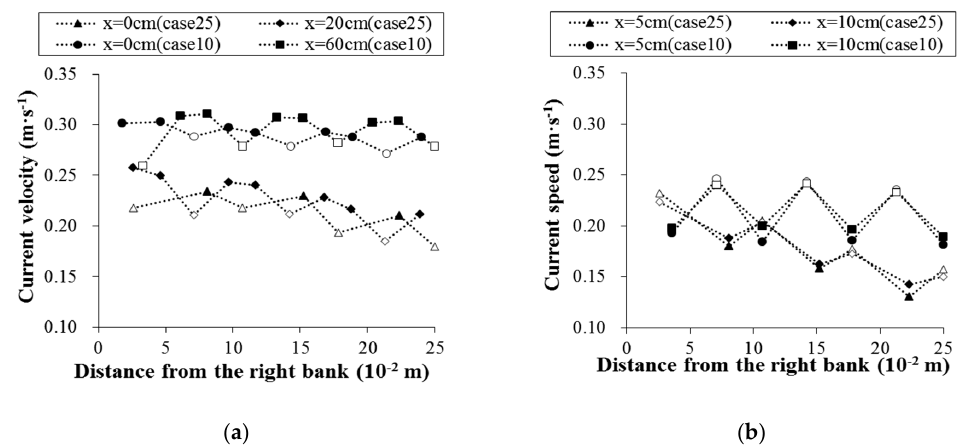
Figure 3. The velocity distribution of different cross sections (the solid and hollow symbols represent the velocities of areas A and B, respectively; the x axis represents the distance from the column): ( a ) The velocity distribution of the cross section of the column; ( b ) the velocity distribution of the downstream cross section of the column.